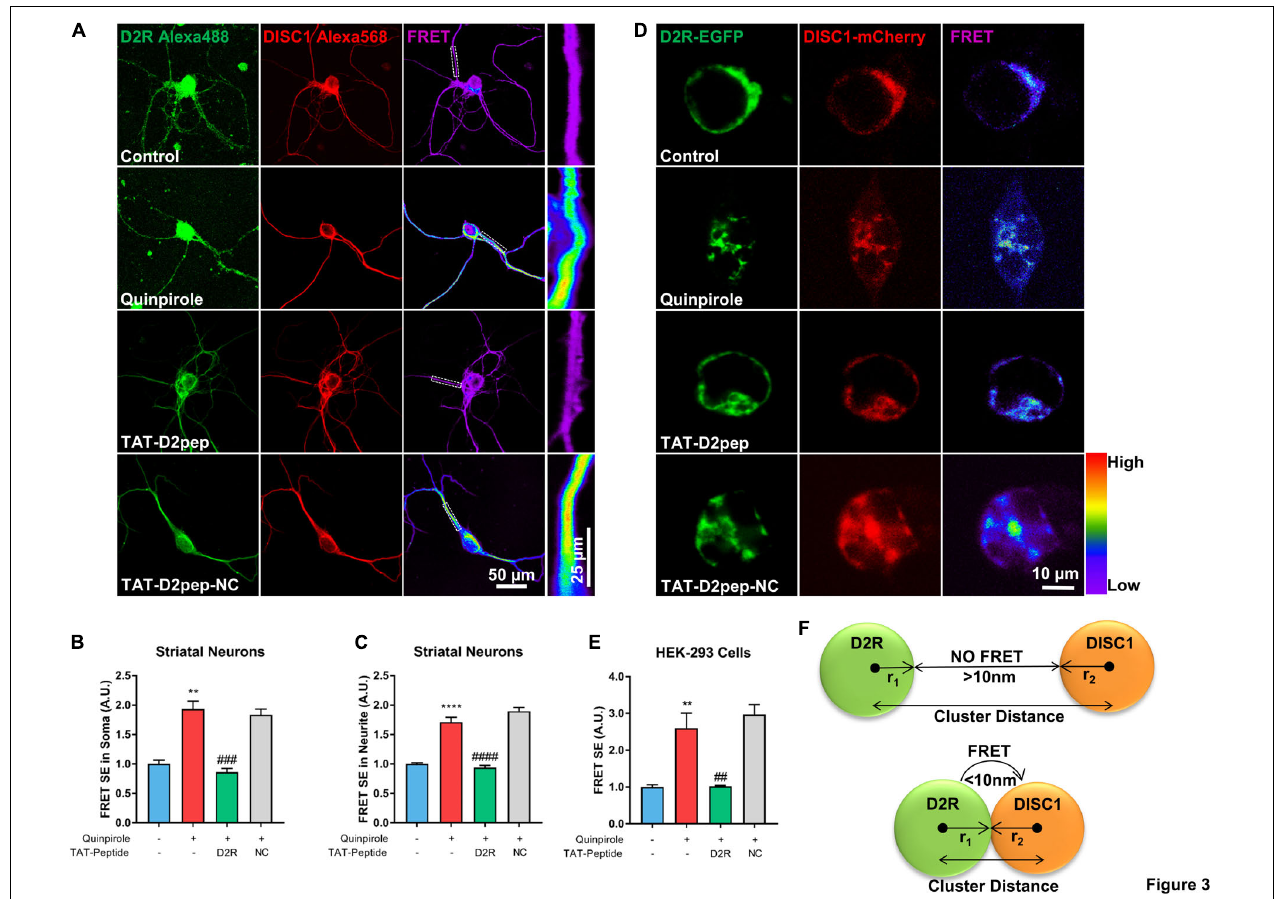
FIGURE 3 | TAT-D2pep specifically blocks excessive D2R–DISC1 complex formation induced by D2R hyperactivity. (A–C) FRET analysis showed that TAT-D2pep decreased D2R–DISC1 complex formation induced by quinpirole in soma and neurites of striatal neurons. In (A) , the boxes in the FRET images are enlarged in the panels to the right. (D,E) FRET images of HEK-293 cells transfected with D2R-EGFP and DISC1-mCherry. D2R hyperactivity-induced D2R–DISC1 complex formation was abolished by TAT-D2pep but not control peptide. Scale bar = 10 µ m. (F) Schematic relationship between FRET and nanocluster distance: r 1 : radius of D2R nanocluster; r 2 : radius of DISC1 nanocluster. If the D2R–DISC1 nanocluster distance is below the sum of r 1 + r 2 + 10 nm, FRET will occur; If the D2R–DISC1 nanocluster distance is above the sum of r 1 + r 2 + 10 nm, FRET will not be detected. Data are shown as means ± SEM and normalized; ** P < 0.01 and **** P < 0.0001 versus control, ## P < 0.01, ### P < 0.001 and #### P < 0.0001 versus quinpirole by one-way analysis of variance (ANOVA) with post hoc Tukey test; n > 30 cells per